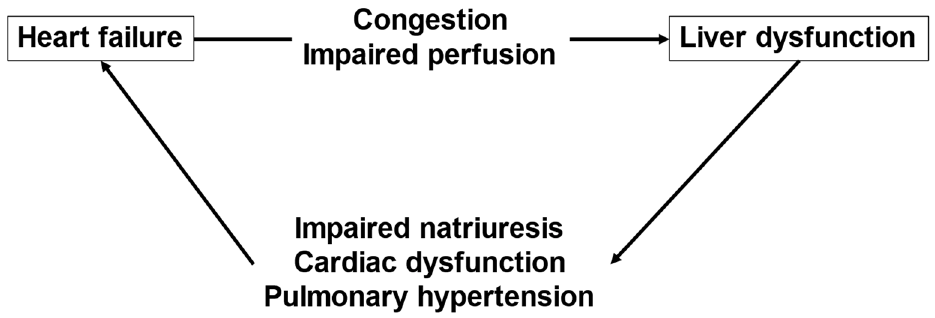
Figure 2. The interaction between heart failure and liver